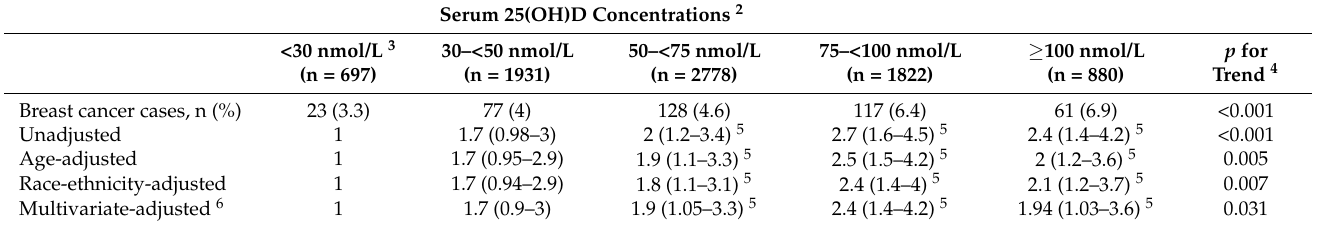
Table 2. Association between serum 25-hydroxyvitamin D [25(OH)D] concentrations and breast cancer prevalence in postmenopausal women in the USA: National Health and Nutrition Examination